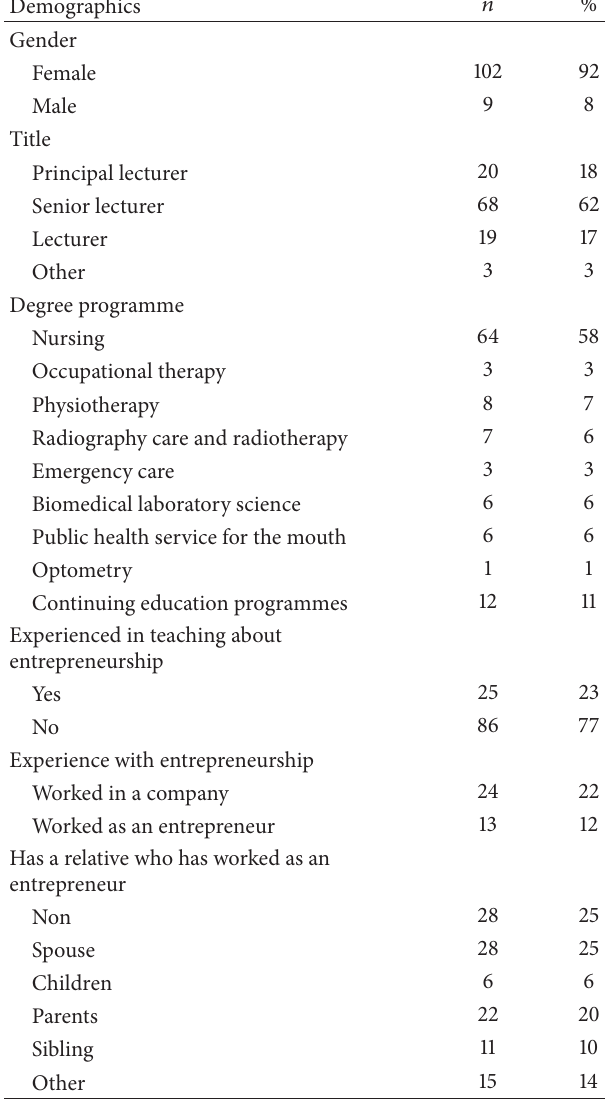
Table 1: Demographic characteristics of the teachers ( 𝑛 = 111